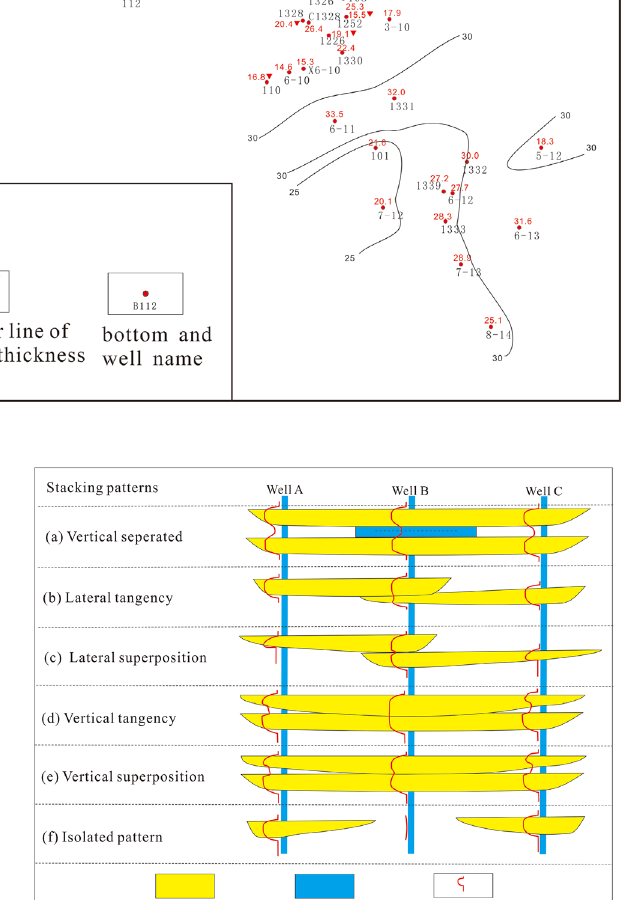
Fig. 9 Sandbody thickness of the different layer in Baobei District, Baolang oilfield